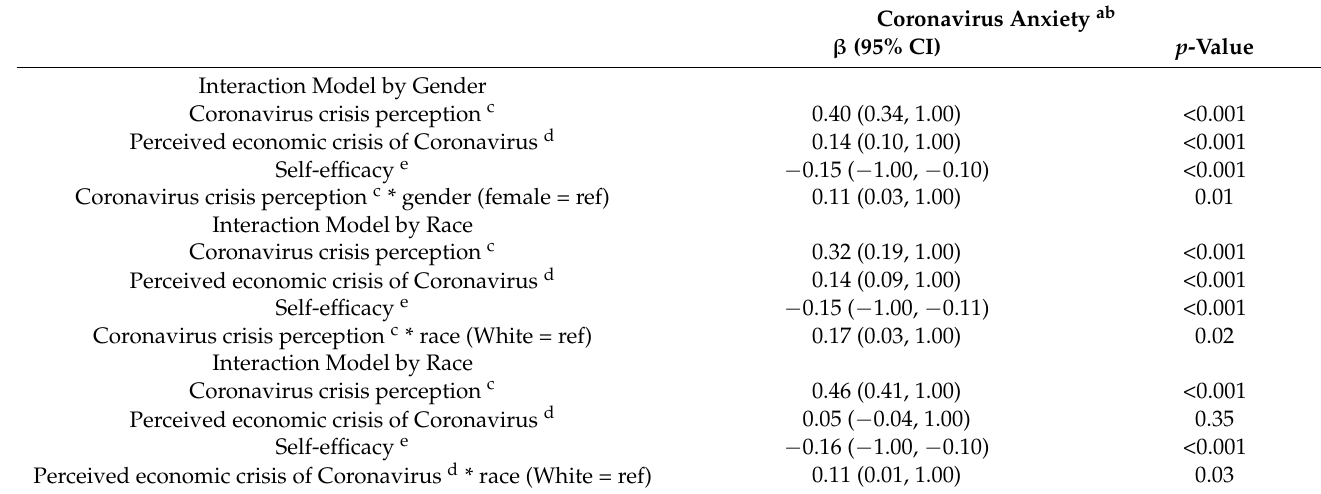
Table 3. Associations Between Cognitive Factors and Coronavirus Anxiety by Gender and Race.